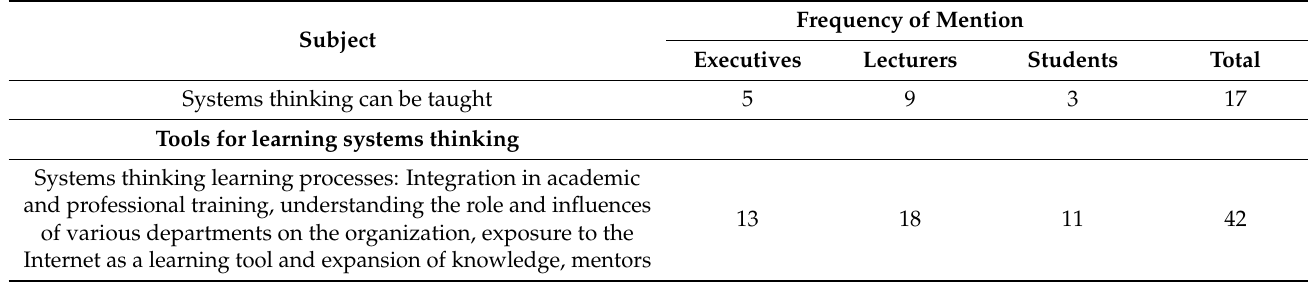
Table 1. Interview